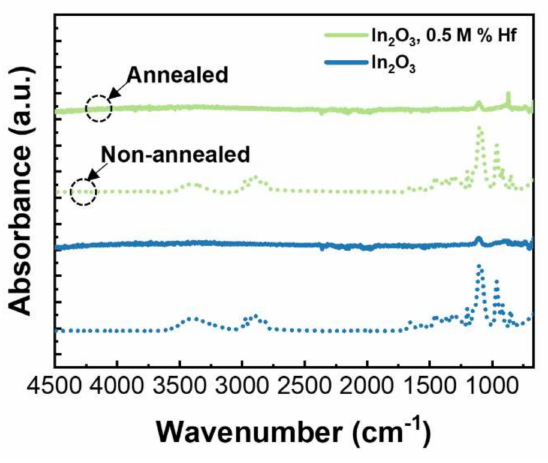
Figure 2. FTIR spectra of undoped and Hf-doped In 2 O 3 thin films, before and after annealing. Table 2. Thickness, transmittance on the visible region and optical bandgap of Hf-doped indium oxide thin